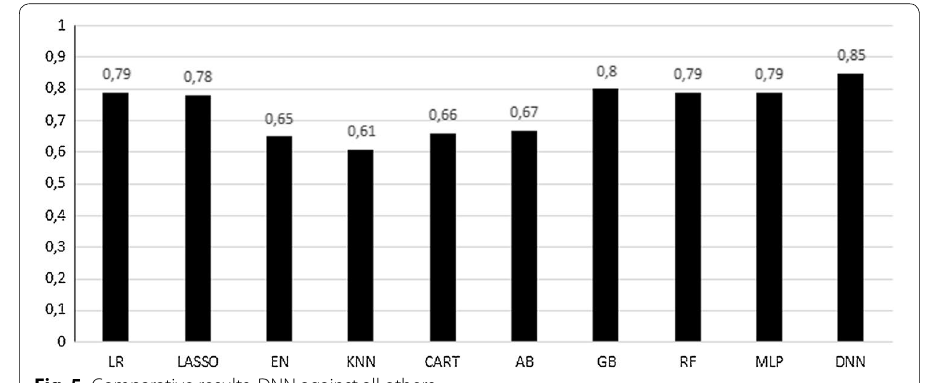
Fig. 5 Comparative results: DNN against all